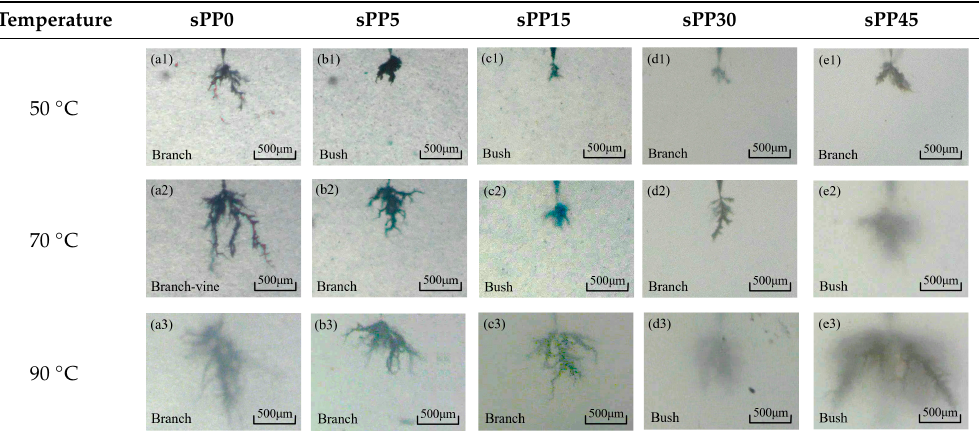
Table 2. Electrical tree morphology of iPP/sPP blends at 50, 70, and 90 °C under AC voltage of 6 kV for 40 min.